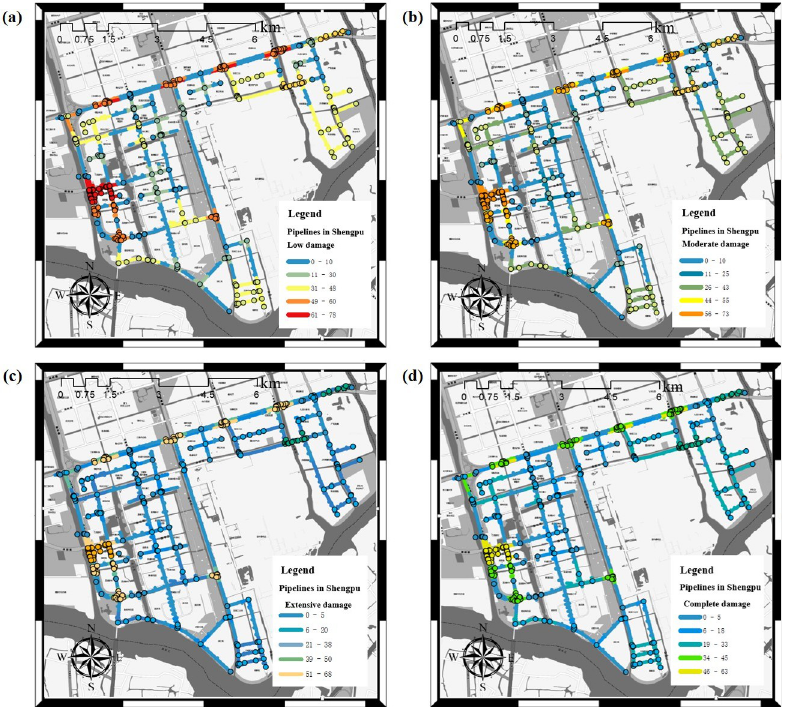
Fig 17. Failure probability of four damage levels to the pipeline network (PGA = 0.2g). (a) Low damage, (b) Moderate damage, (c) Extensive damage, (d) Complete damage. (Republished under a CC BY license, with permission from Suzhou Industrial Park Qingyuan Huayan Water Co. LTD, original copyright 2019).